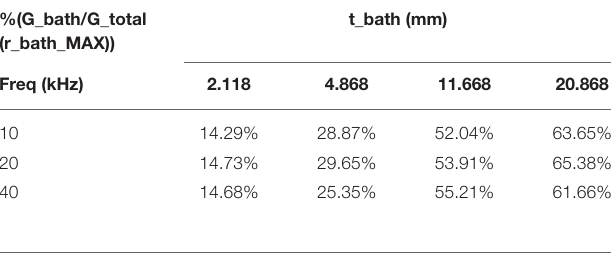
TABLE 4 | Ratio of experimental values of parallel conductance to the total conductance as function of the bath thickness at different frequencies, TR = 0.79.